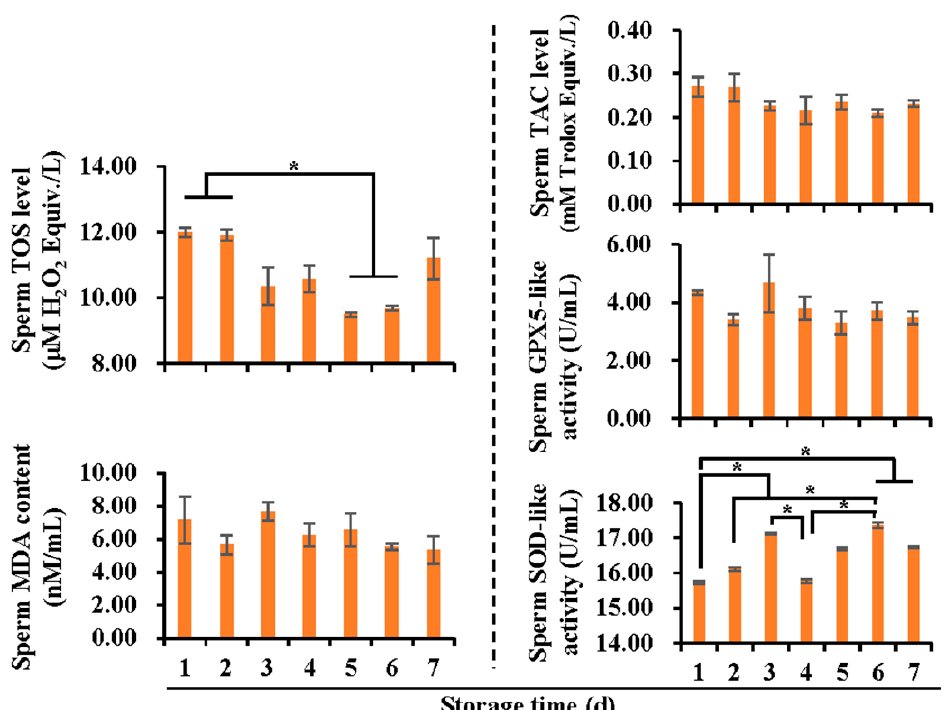
Figure 2. Histograms showing antioxidant and oxidant levels in spermatozoa, according to storage time (days). TOS: total oxidant status, MDA: malondialchehyche, TAC: total antioxidant capacity, GPX5: glutathione peroxidase 5, SOD: superoxide dismutase. Data were pooled from 18 Duroc boars and expressed as mean ± SEM. * indicates differences among groups, p < 0.05.